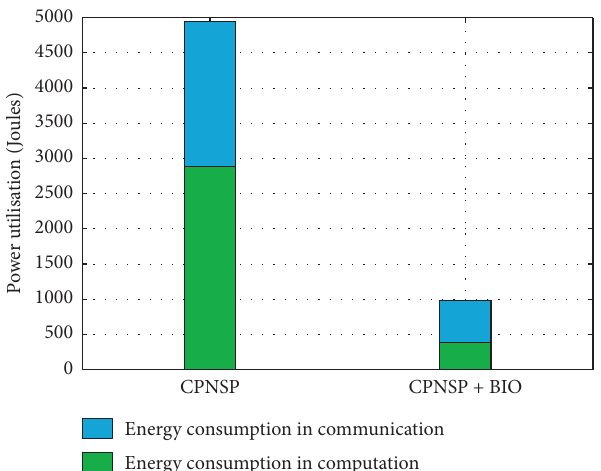
Figure 6: The total energy consumption of each algorithm for a two minute long evacuation process. The blue bar represents the overall energy consumption in communication process while the green bar shows the total energy consumption of microprocessors.